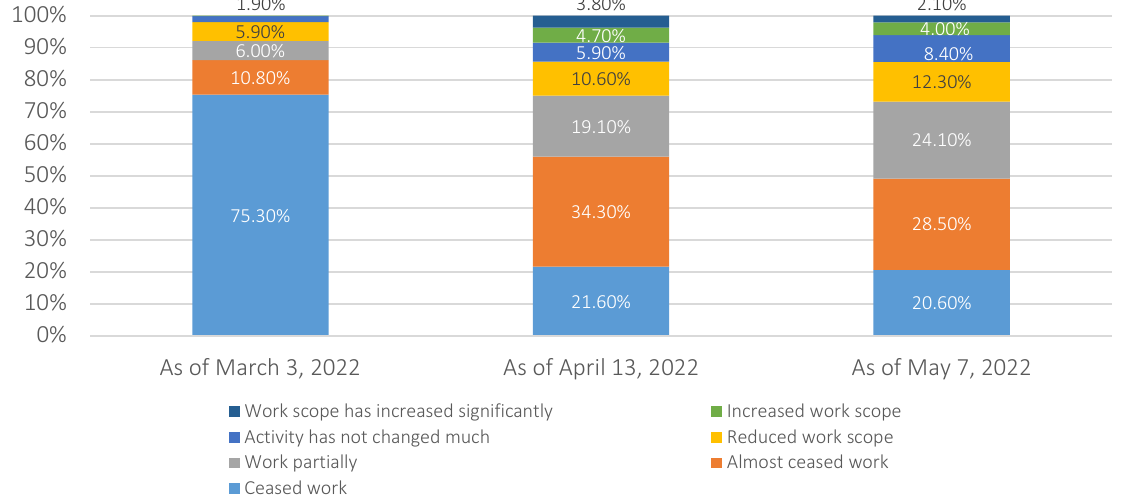
Figure 1. The state of business activity in Ukraine (in relation to February 24)